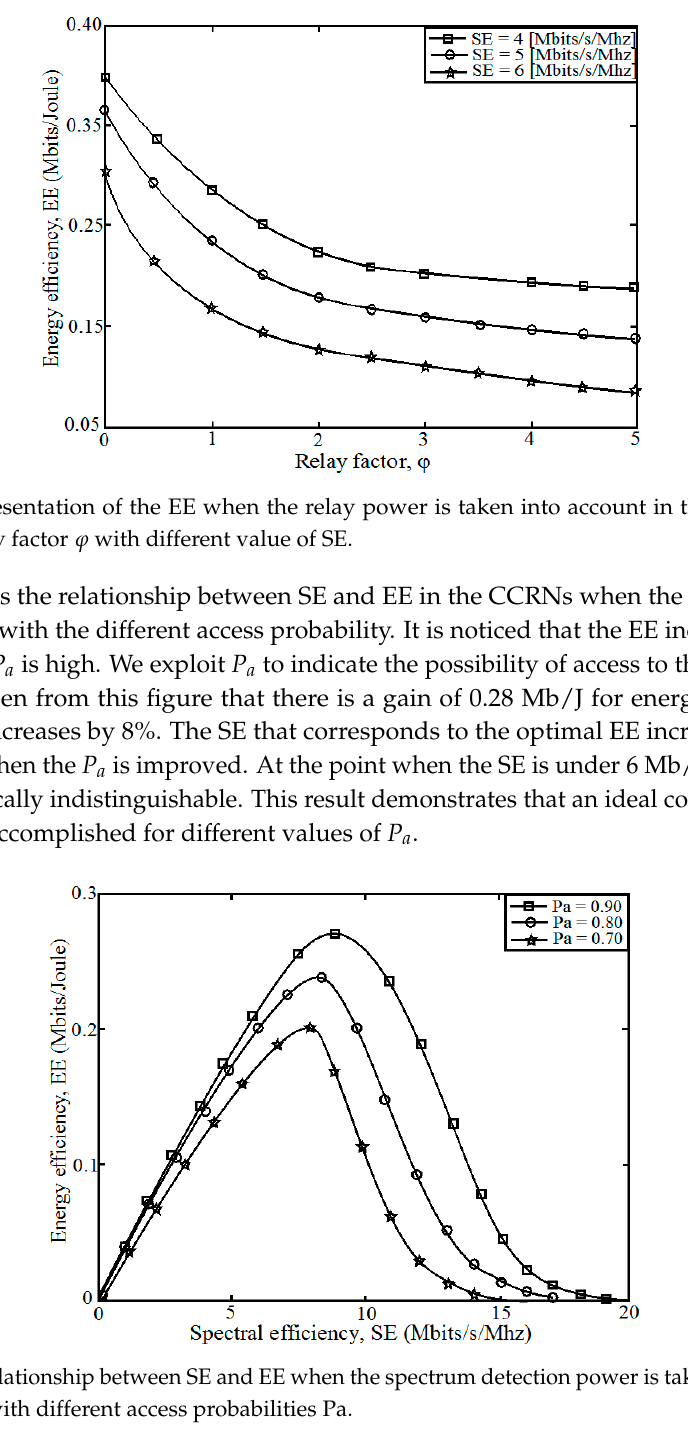
Figure 9. Representation of the EE when the detection power is considered in the CCRNs as a function of the probability of access to different detection factors θ . Focusing on (44), the relation between the P a and the SE with the different detection factors θ in the CCRNs is shown in Figure 10. The total power Z consumed is decided at 30 dBm. In this figure, it is noticed that CCRNs with better detection capability can get better SE. The gain of SE is approximately at 0.28 Mb/s/MHz for P a = 0.95 and when the detection factor φ leaves from 2 to 0.8.